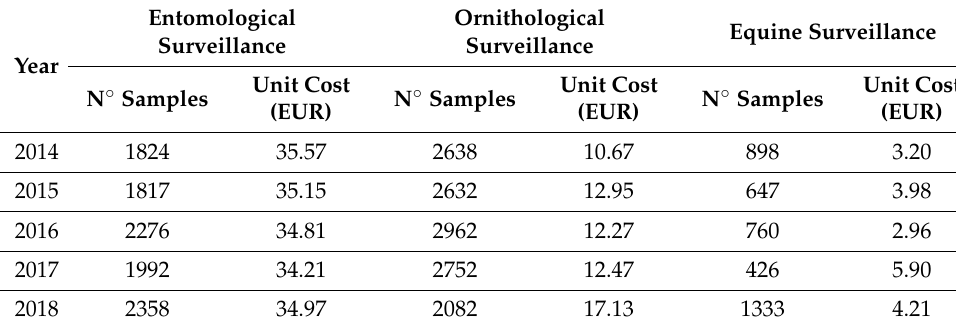
Table 2. Annual number of specimens and unit cost per analysis (including equipment and human resources for both collection of specimens and laboratory